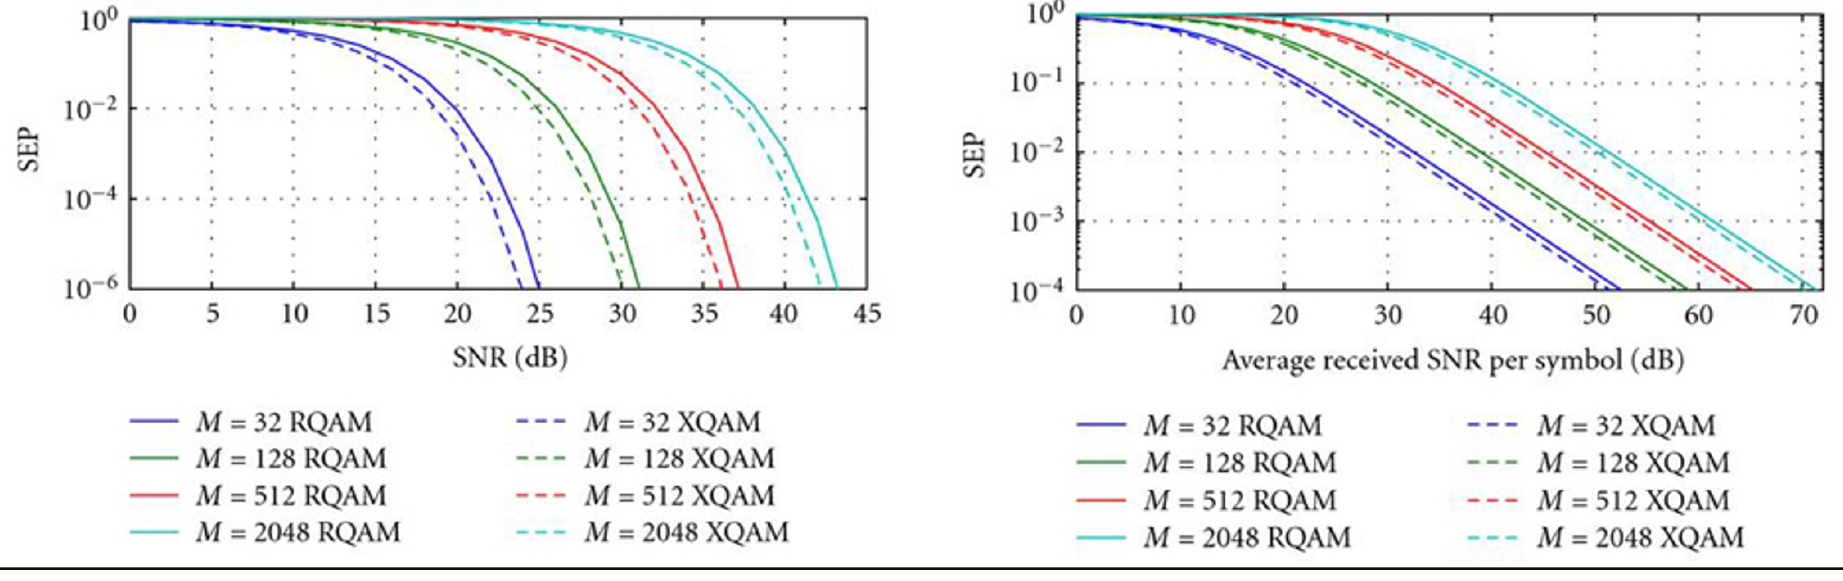
Figure 7 SNR gain of cross-QAM over rectangular QAM. AWGN ChannelsRayleigh